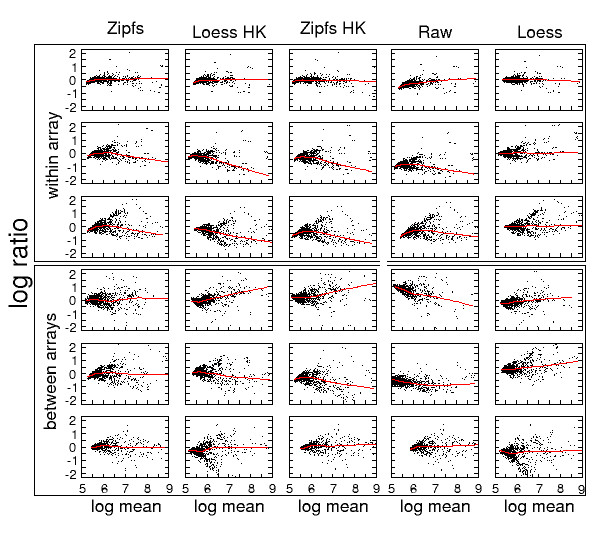
Boutique microarray MA plots. MA plots of the boutique data set comparing (in columns) Zipf's normalization using controls (Zipfs), Zipf's normalization using housekeepers (Zipfs HK), loess normalization using housekeepers (loess HK), raw data, and, for comparison purposes only, the standard loess normalization. Each row of plots represents one pairwise comparison, only 6 of the possible 45 pairwise comparisons of the 5 microarrays used in figure 4 are shown. The top three rows show within-array comparisons, and the bottom three rows show between-array comparisons. Lowess curves are plotted in red.